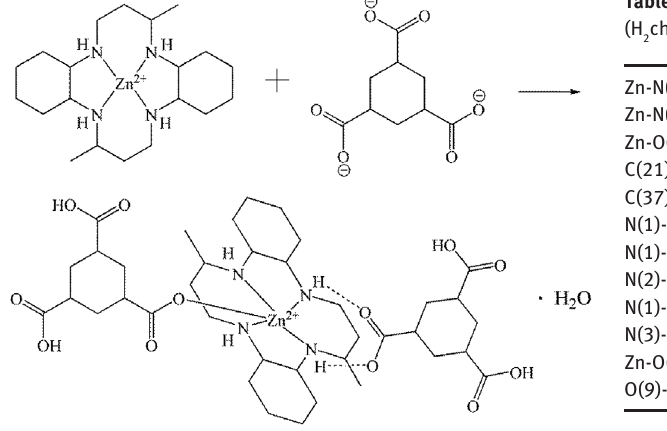
Figure 1: An ORTEP drawing (30% probability ellipsoids) of [Zn(L)( H The hydrogen bonds are shown as dashed lines. Symmetry codes: (#viii) x+2, y, z+1; (#ix) x+1, y, z+1.